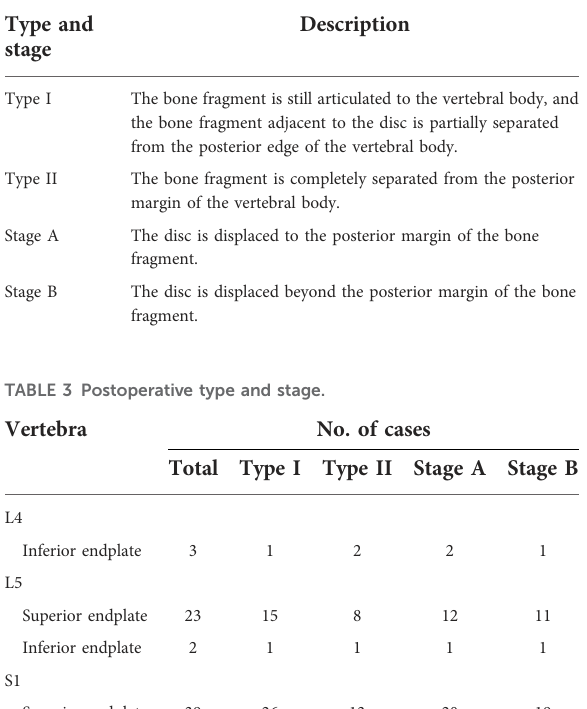
TABLE 2 Type and stage of PRAS.